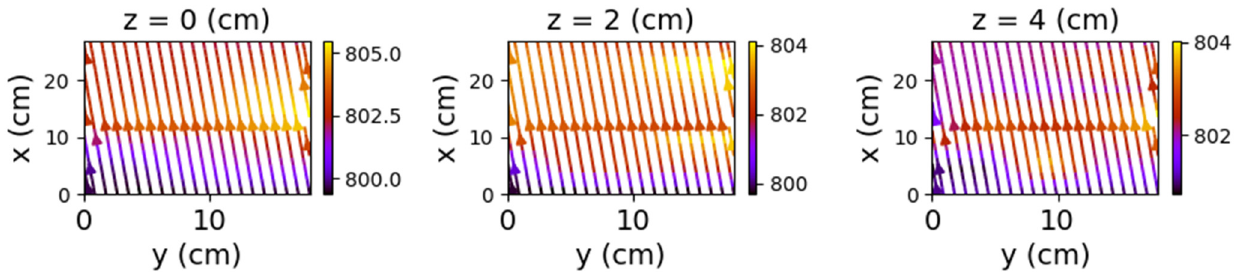
Figure 11. Field lines for x O y plane—non-powered relay.